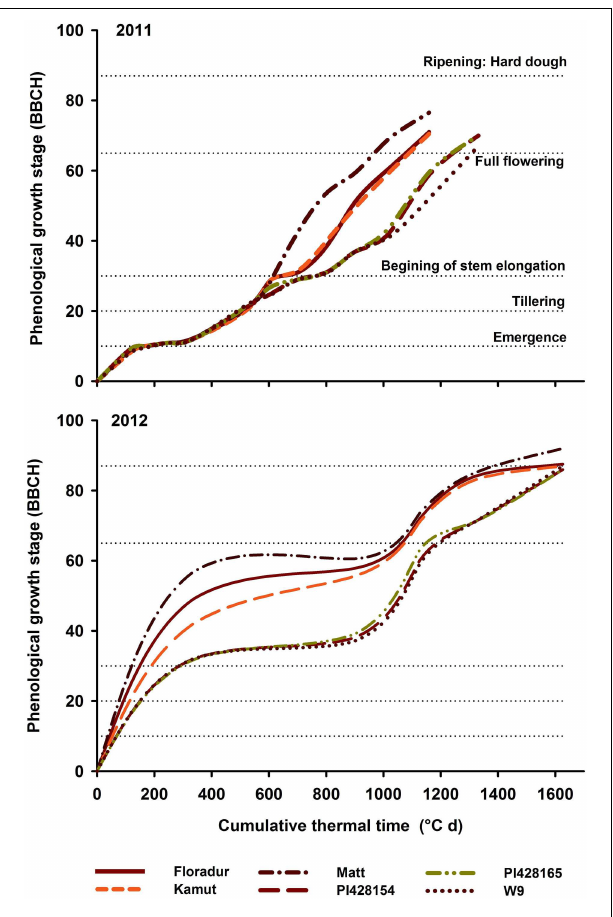
FIGURE 3 | Genotypic variation in phenological growth development of core set genotypes in 2011 and 2012. In each year the cumulative thermal time (CTT) was calculated from the day of sowing